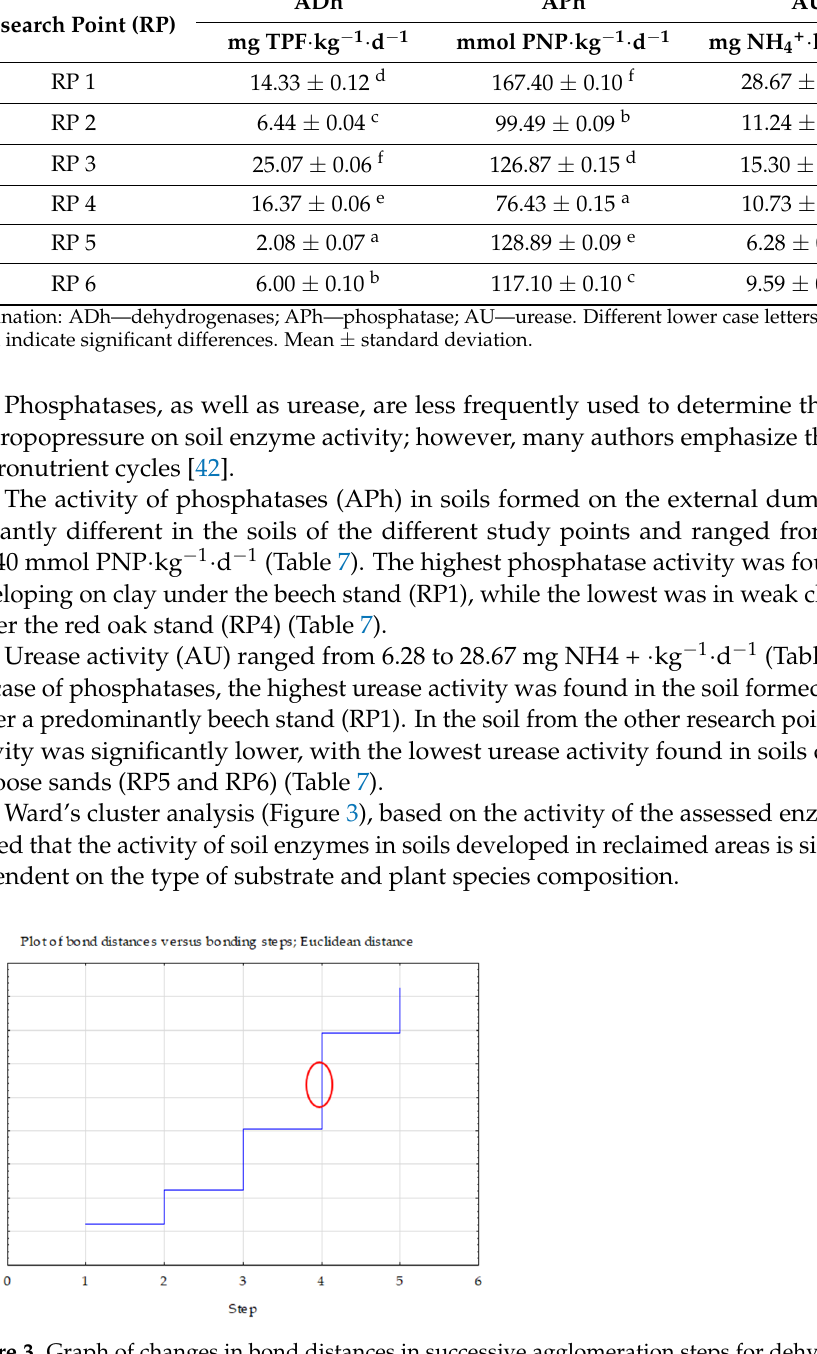
Figure 3. Graph of changes in bond distances in successive agglomeration steps for dehydrogenases, phosphatase and urease.